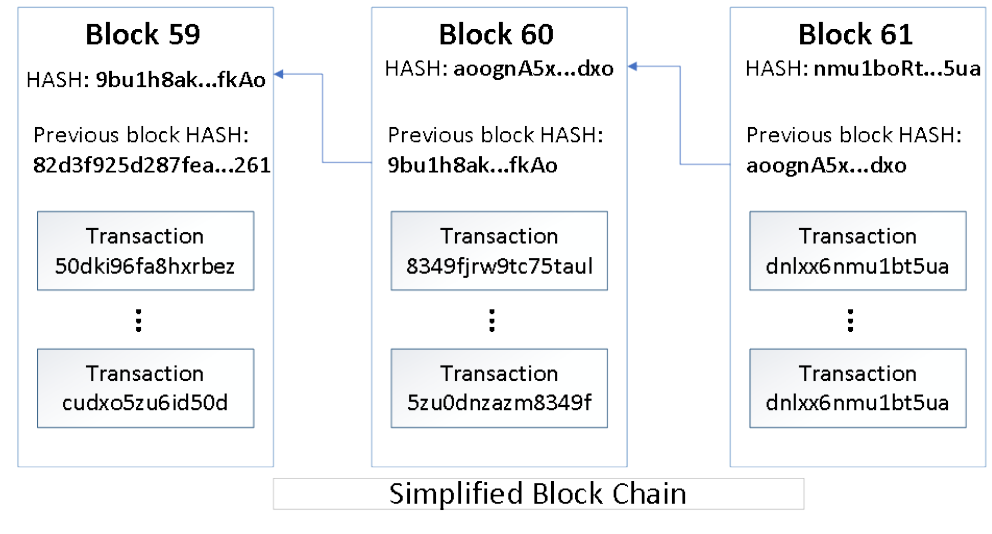
Figure 1. Blocks committed in a ledger.